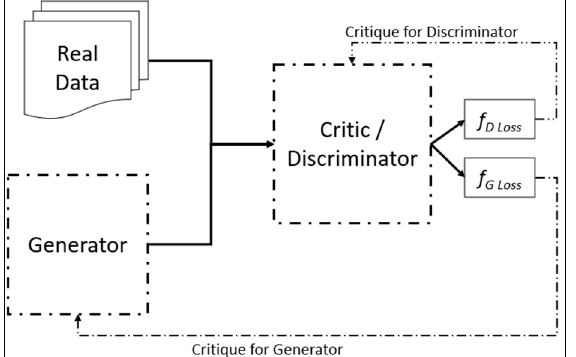
Figure 1. WGAN architecture.